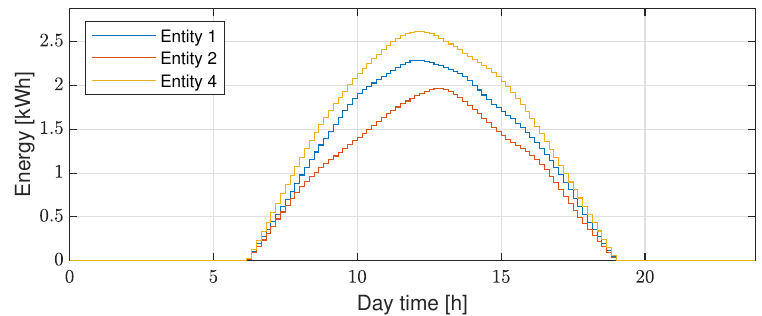
Figure 6. Example 3. Non-steerable generation profiles in day